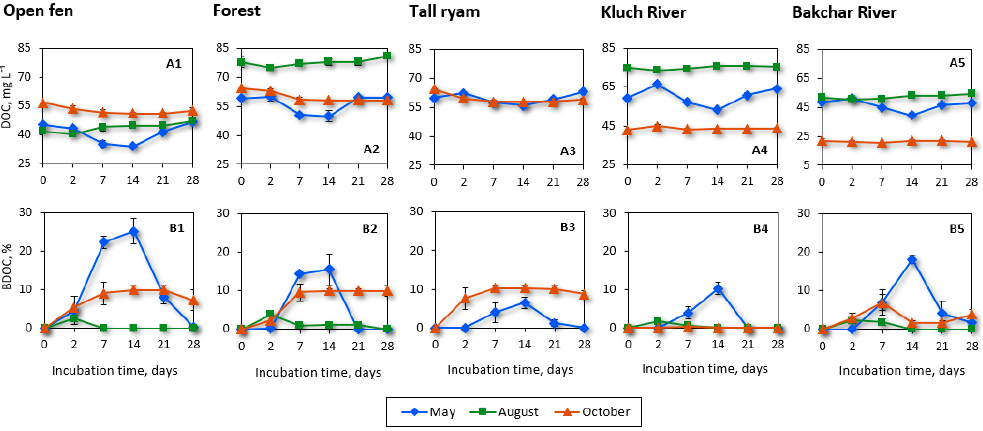
Figure 4. DOC concentration (mg L − 1 , ( A1 – A5 )) and BDOC (%, ( B1 – B5 )) along the aquatic continuum by season during incubation time. The error bars are ± 1 SD of the triplicates unless within the symbol